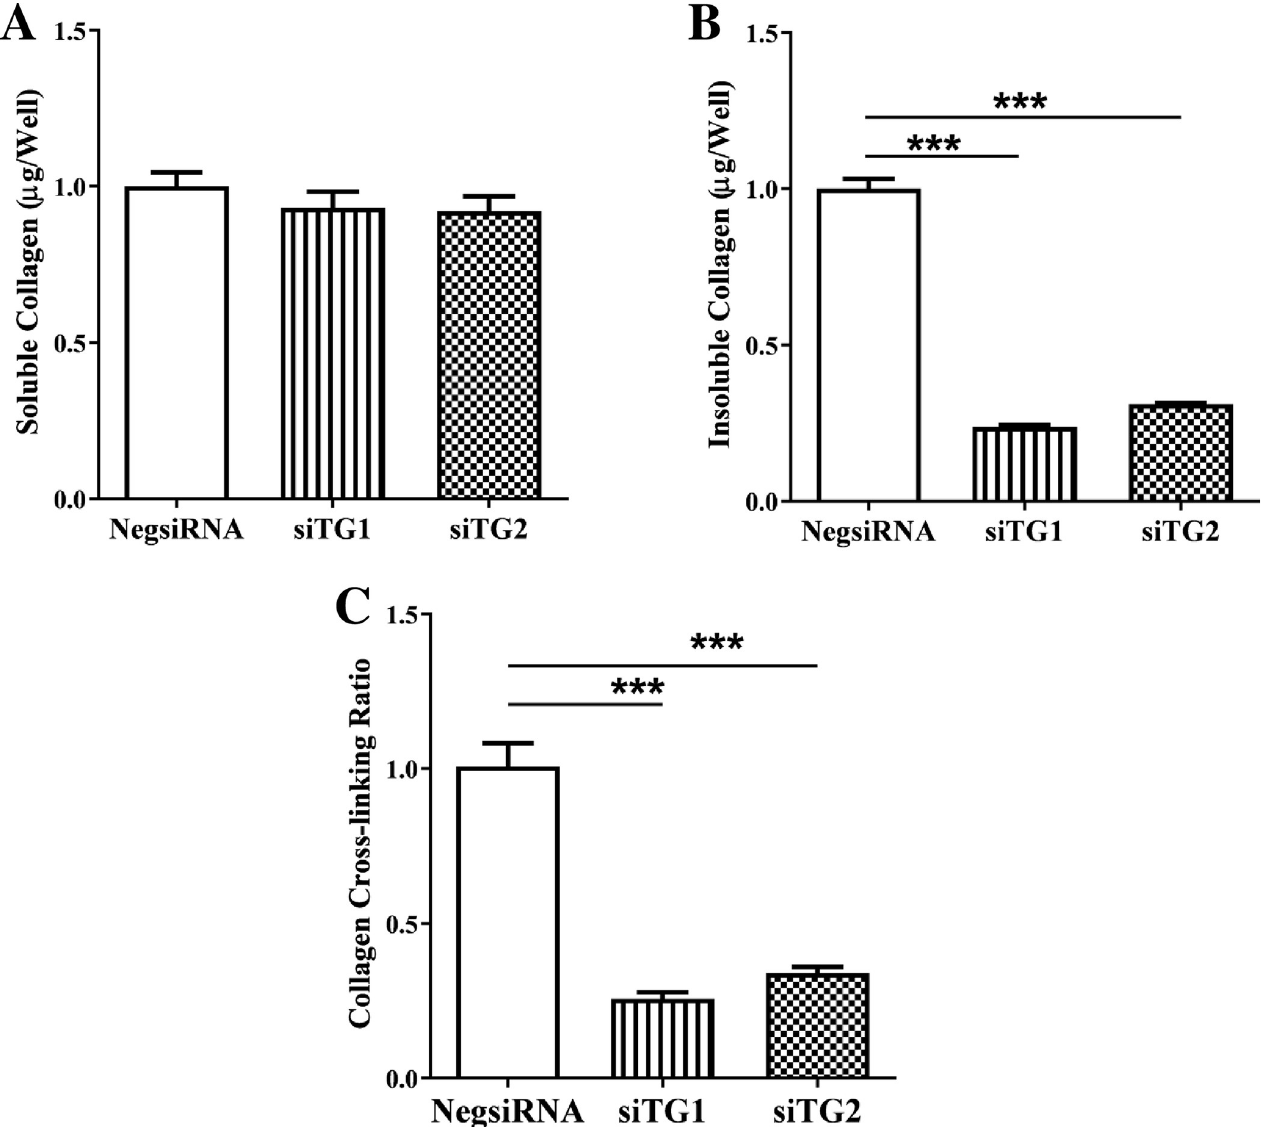
Fig 2. Knockdown of transglutaminase 1 (TG1) and TG2 isoforms diminished the insoluble collagen content and collagen cross-linking ratio without detectable change in soluble collagen in neonatal rat ventricular fibroblasts. Effect of transfection with siTG1 or siTG2 in fibroblasts (n = 3 replicates) on relative (A) soluble collagen content, (B) insoluble collagen content, and (C) collagen crosslinking ratio as compared with the negative control (NegsiRNA). Results are means ± SEM; one-way ANOVA followed by Dunnett’s multiple comparison test was performed. ��� P < 0.001 vs.